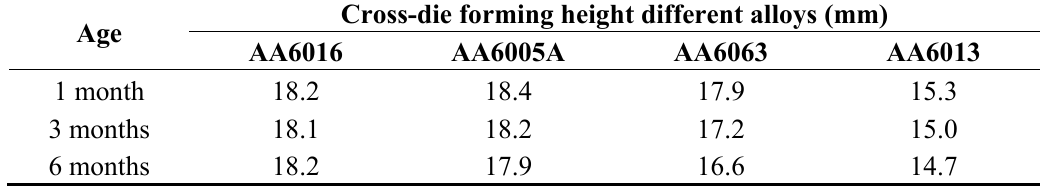
Table 5. Cross-die forming height (in mm) measured one, three and six months after sheet production in temper T4*.